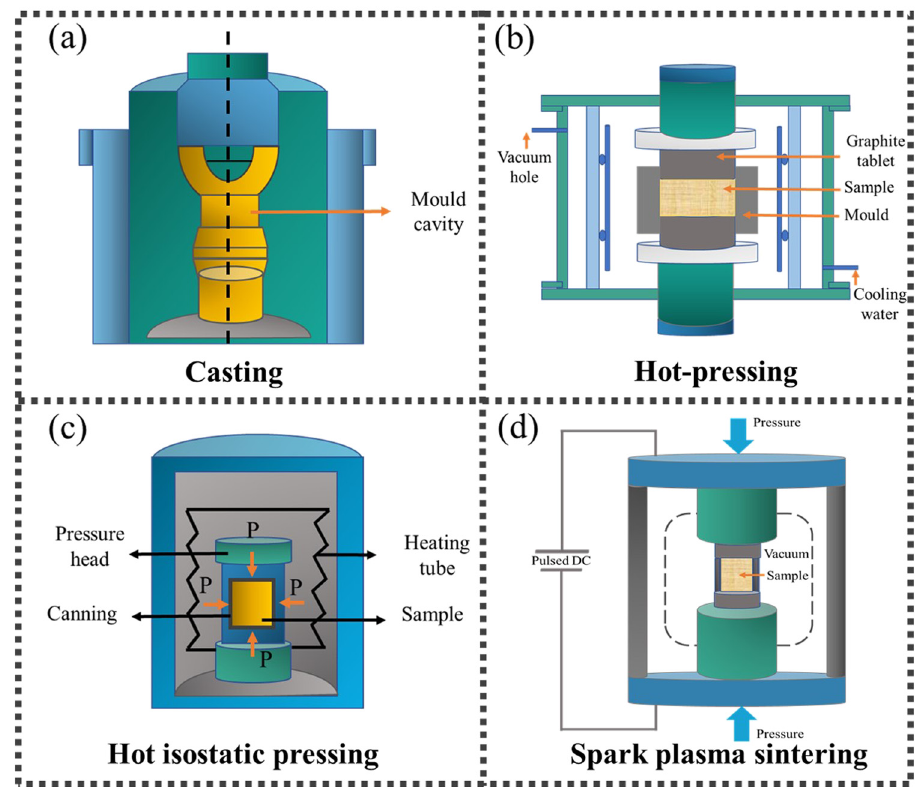
Figure 4: Preparation process of alloy: ( a ) casting, ( b ) hot - pressing sintering, ( c ) HIP, and ( d )